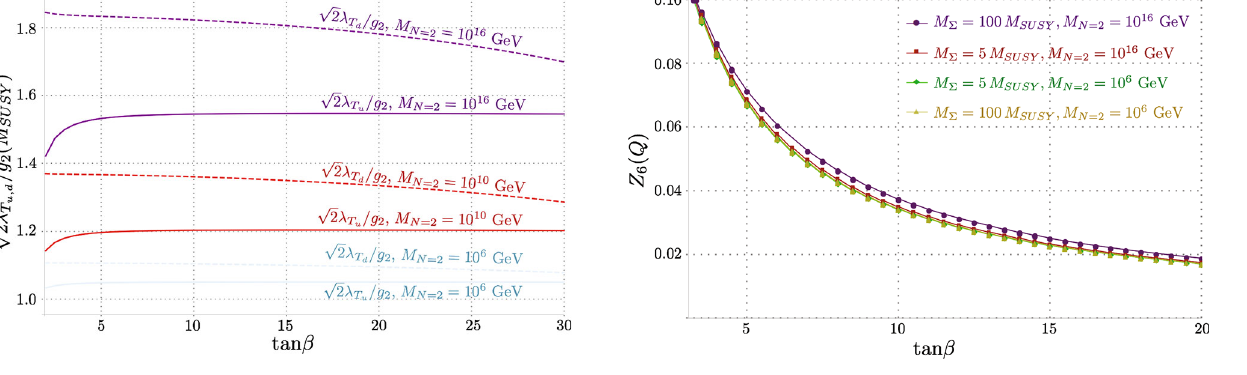
Fig. 10 Variations in the ratio scale for N = 2 scales 10 6 , 10 10 and 10 16 GeV